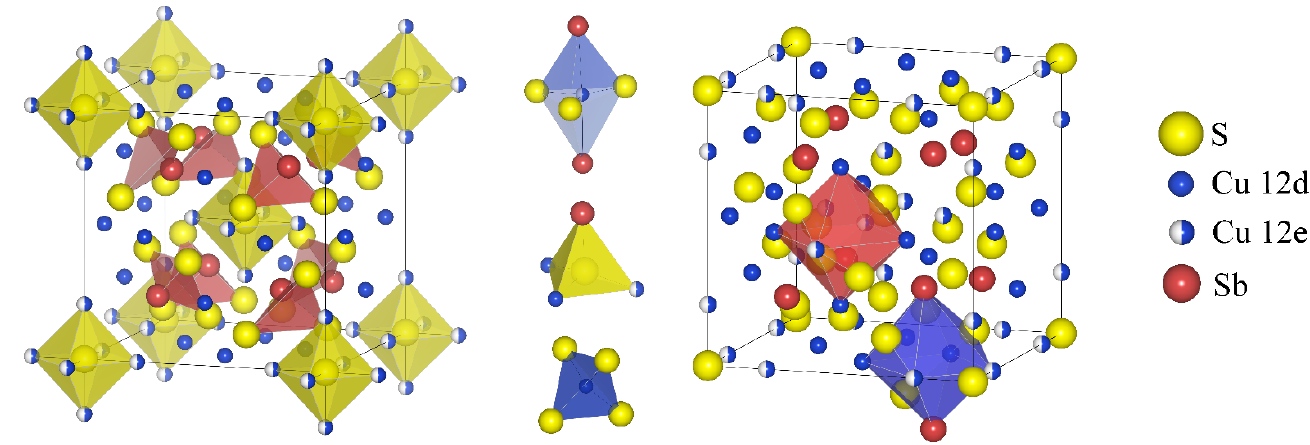
Figure 1. Crystal structure of tetrahedrites with main polyhedra building blocks.